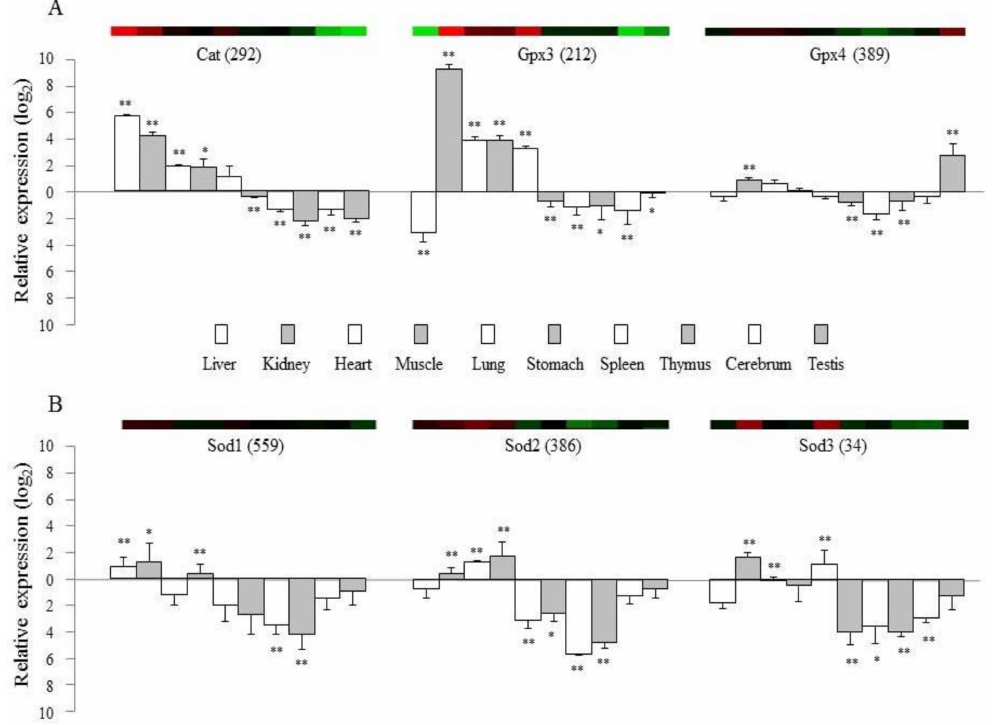
Figure 2. Confirmation of gene expression levels using qRT-PCR. Five mice-derived samples were used for microarray experiment and for qRT-PCR. The top colored panels show the data from microarray analysis, and the bottom graphs present the gene expression results from qRT-PCR for six genes; catalase, catalase ( Cat ), glutathione peroxidase 3 ( Gpx3 ), glutathione peroxidase 4 ( Gpx4 ), and superoxide dismutase 1 to 3 ( Sod1 to 3 ), respectively. The numbers in parentheses indicate the relative transcript levels (the mean signal intensity) of the microarray experiment. Each value represents the mean ± SD. ANOVA indicated p < 0.01. The multiple comparisons are not presented; instead, the relative ratio of each tissue gene expression was compared with the mean expression level of rest 10 tissues. The significance was presented as * p < 0.05 or ** p < 0.01